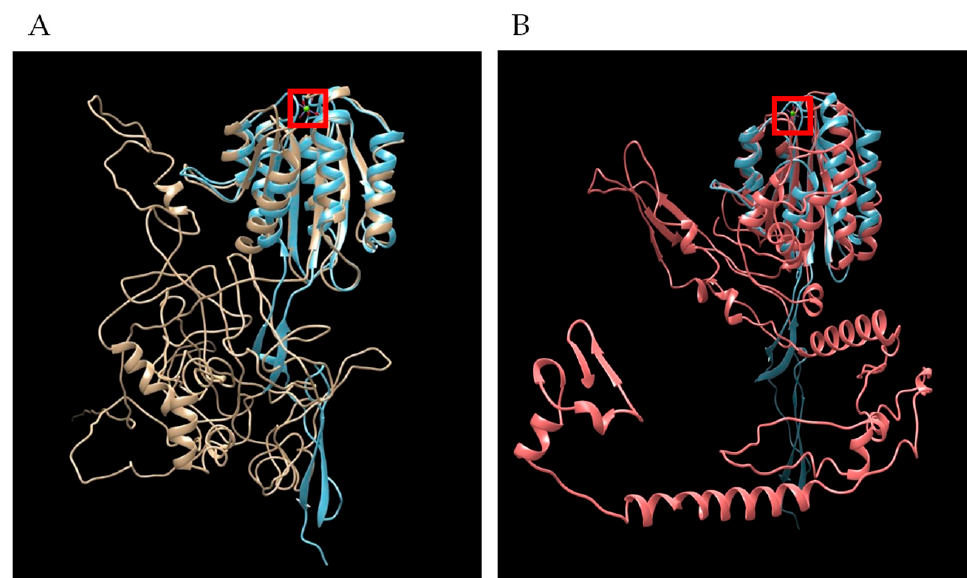
Figure 7. Overlap of secondary structures shared in tertiary models of Plasmodium TRAP with B. bovis TRAP. ( A ) Plasmodium vivax TRAP (4hqlA) is blue and B. bovis TRAP1 is gold and ( B ) Plasmodium vivax TRAP (4hqlA) is blue and B. bovis TRAP4 is red. Image generated by Chimera MatchMaker. Red square is Mg 2+ ion bound by P. vivax TRAP.